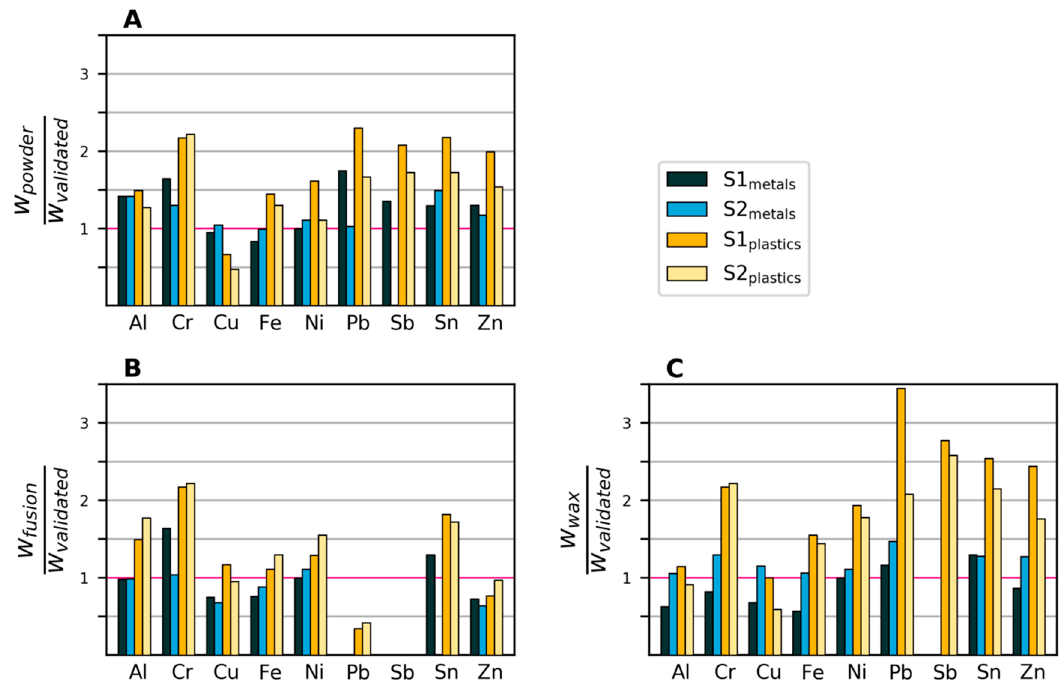
Figure 4. Mass fractions ( w ) measured with XRF divided by mass fractions measured with the validated method. Values that are zero indicate that the element was not detected. A : XRF powder. B : XRF fused bead. C : XRF wax pellet.